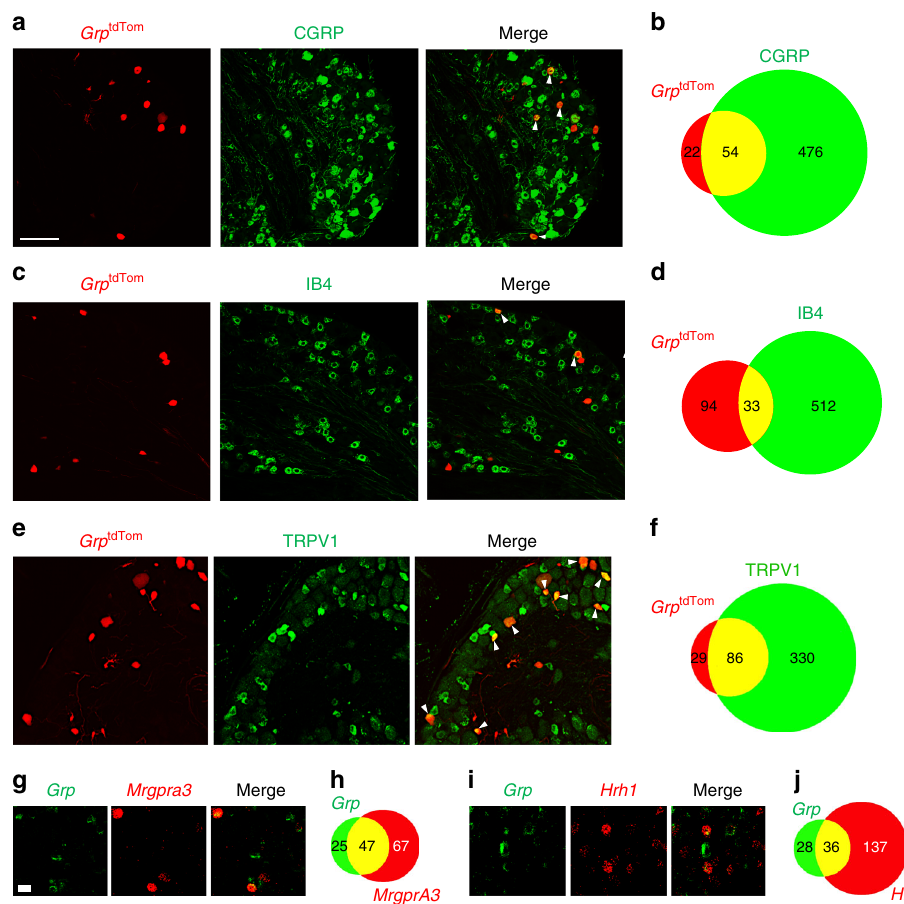
Fig. 3 Grp expression is enriched in a subset of sensory neurons with both peptidergic and non-peptidergic markers. a , c , e IHC image of tdTomato with CGRP ( a ), IB4 ( c ), and TRPV1 ( e ) in Grp tdTom DRG. Arrowheads indicate double stained neurons. Scale bar, 50 μ m. b , d , f Venn Diagram of DRG neurons with tdTomato/CGRP expression, tdTomato/IB4-binding, and tdTomato/TRPV1 expression from Grp tdTom mice. g ISH of Grp and Mrgpra3 in WT DRG. Scale bar, 20 μ m. h Diagram of DRG neurons with Grp and Mrgpra3 expression. i ISH of Grp and Hrh1 in WT DRG. j Diagram of DRG neurons with Grp and Hrh1 expression. n = 3 mice and 9